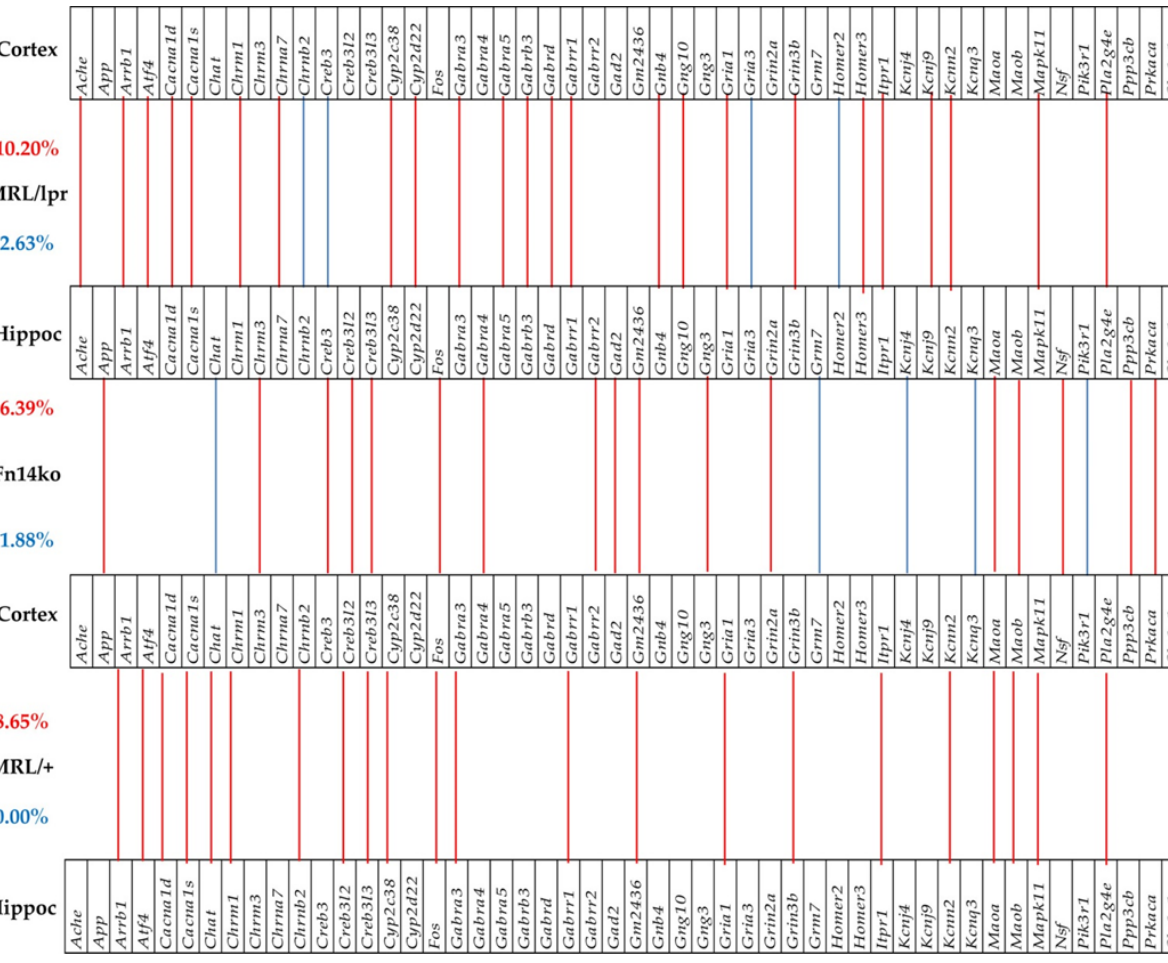
Figure 6. Significant in-phase and anti-phase expression of neurotransmission genes between the cortex and hippocampus in each phenotype. Red/blue lines indicate the genes that are significantly expressed in-phase and antiphase between the two regions. Red numbers indicate percentages of in-phase, and blue numbers of anti-phase expressions.